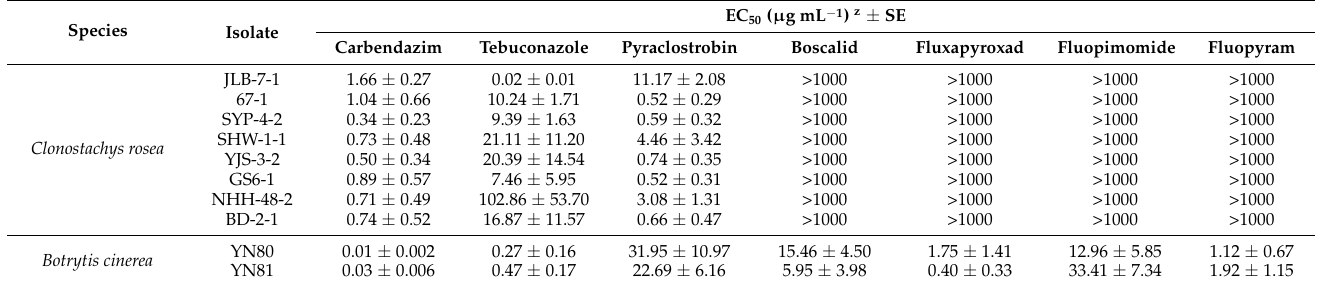
Table 1. Fungicide sensitivities of the Clonostachys rosea and Botrytis cinerea isolates to carbendazim, tebuconazole, pyraclostrobin, boscalid, fluxapyroxad, fluopimomide, and